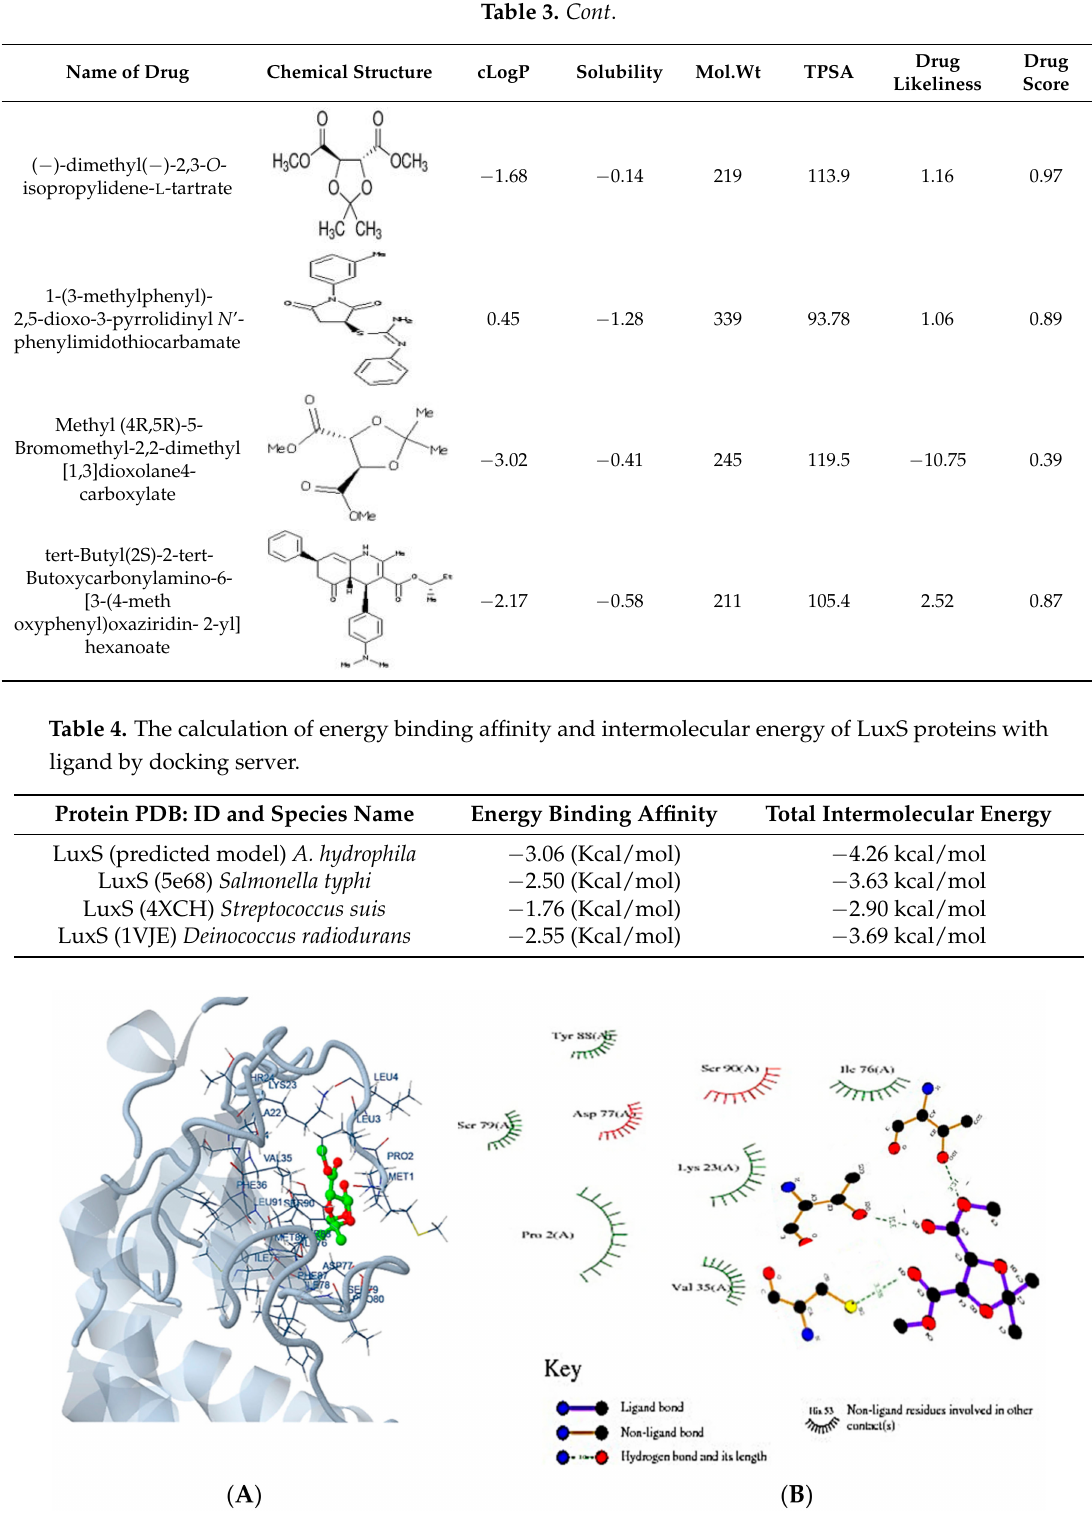
Figure 6. ( A ) ligand-protein complex docked by dock server ( B ) the schematic illustration interaction of dimethyl ( − )-2,3- O -isopropylidene- L -tartrate ligand molecule with predicted LuxS protein